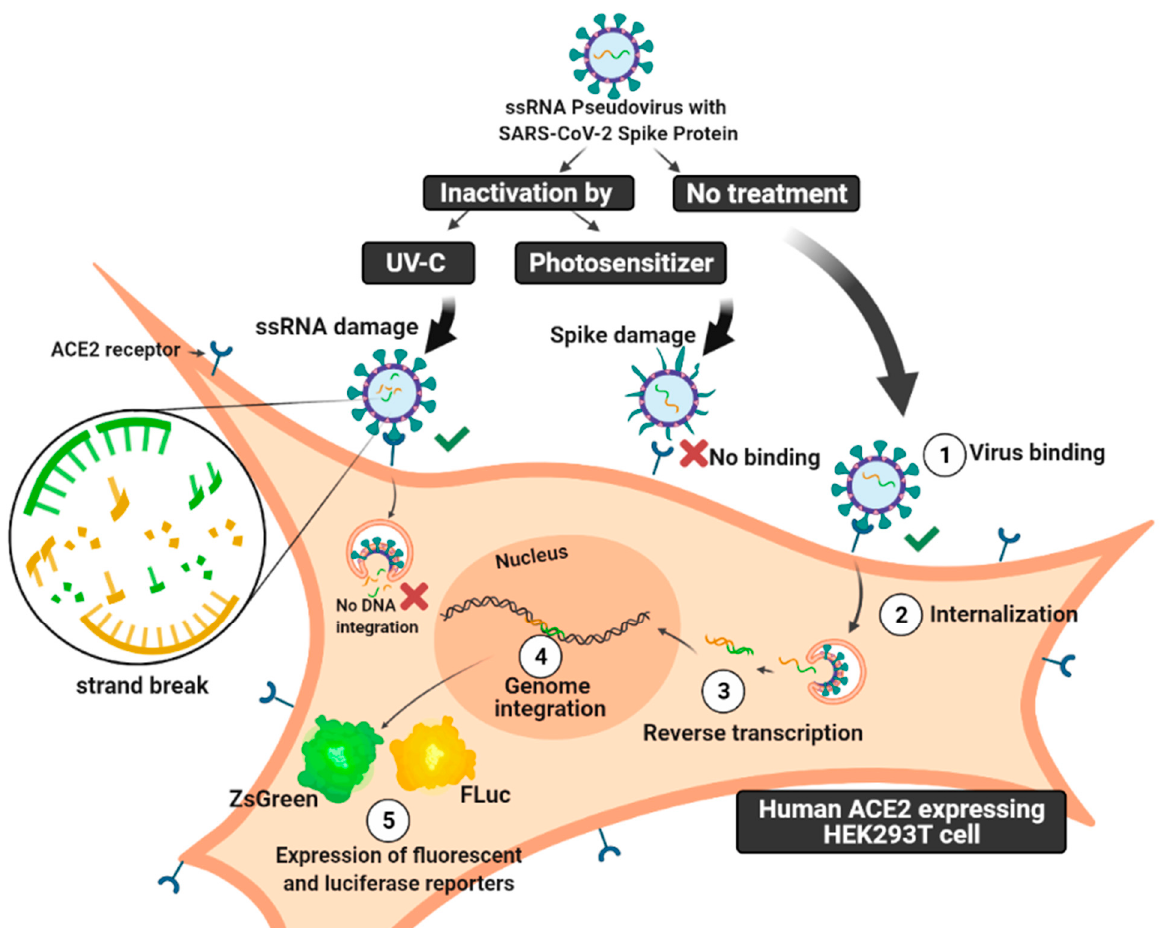
Figure 1. Schematic picture of the mechanism of SARS-CoV-2 pseudovirus infectivity. Unlike SC2 ssRNA virus, which has viral reproduction independent of the host genome, this counterpart pseudovirus carries on reporter ssRNA with LTR, which causes integration into the genome. In this study, the pseudovirus has been treated with either UV-C irradiation or photodynamic inactivation (PDI) by Photodithazine photosensitizer. The mechanism of infectivity of photo-inactivated pseudovirus particles has been compared on four levels; free-cell viral damage; viral cell entry; DNA integration; and expression of reporter genes. The figure was created with BioRender software.